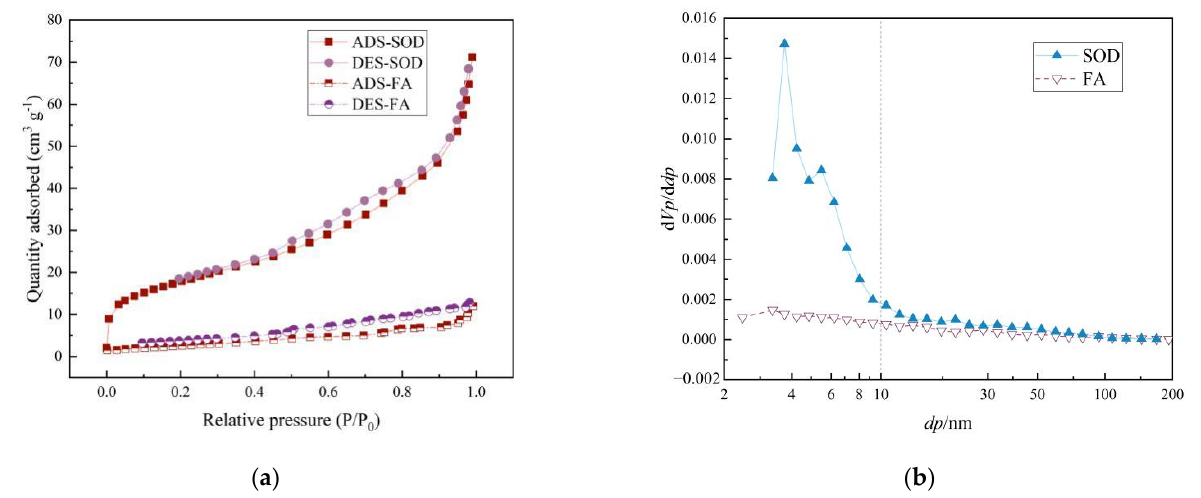
Figure 4. BET test results of raw material FA and synthetic product SOD ( a ) N 2 physisorption isotherm and ( b ) pore size distribution calculated by BJH method.